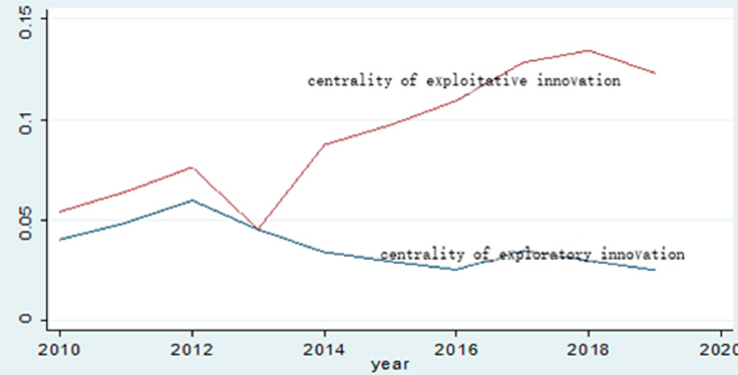
Figure 8. Change curve of centrality based on dual innovation strategy.